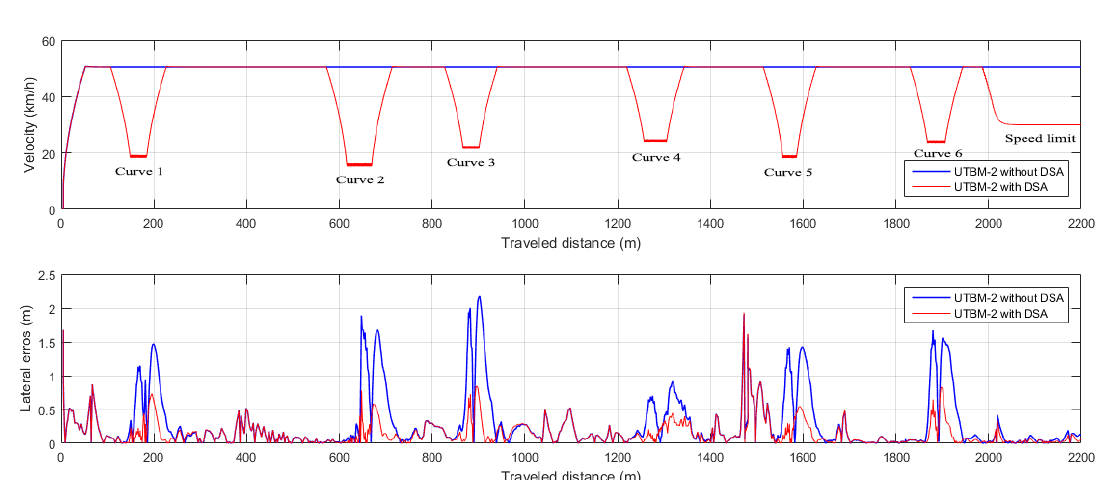
Figure 15. Speed ( top graph ) and lateral error ( bottom graph ) comparison in the UTBM-2 dataset using the PP method with and without DSA.